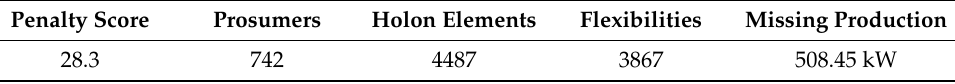
Table 2. Summary of information about the undersupply situation for the example grid.